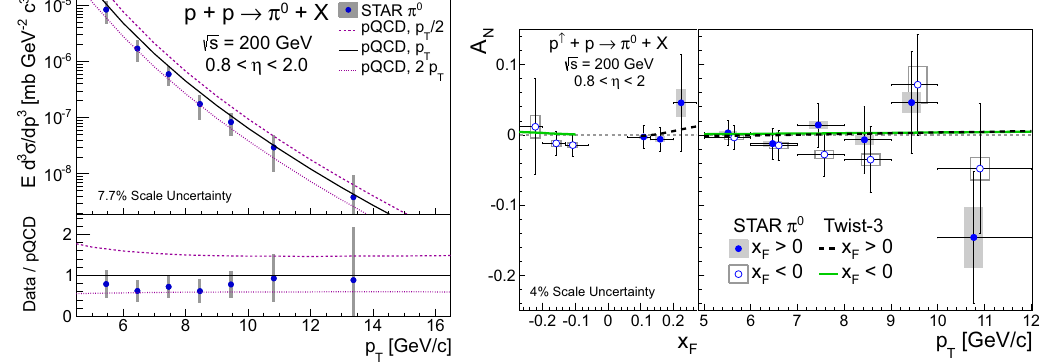
Figure 5. (Left) Cross sections (left) and A N (right) for inclusive neutral pions produced at mid-central rapidity (0 . 8 < η < 2 . 0) [24].